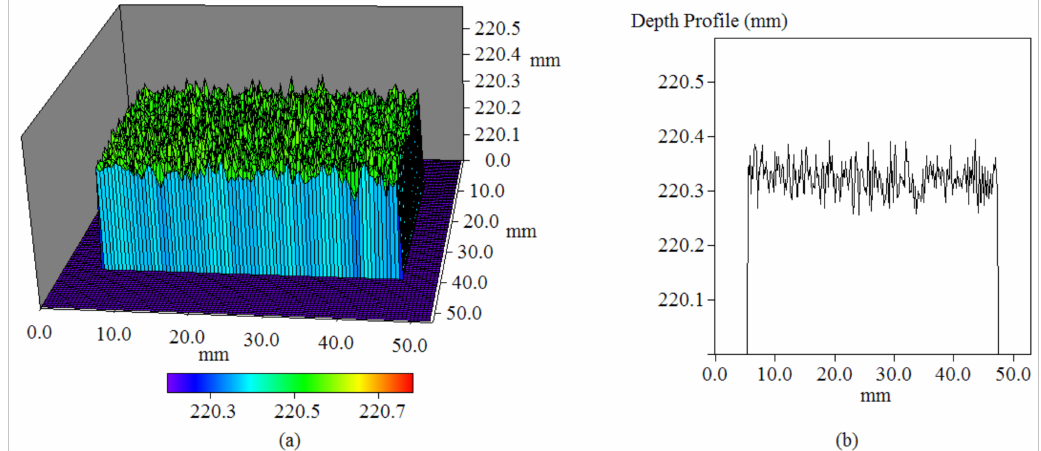
Figure 12. ( a ) The profile that was retrieved by means of combining binary-coding and phase-shifting projections. ( b ) One- dimensional profile distribution along the x